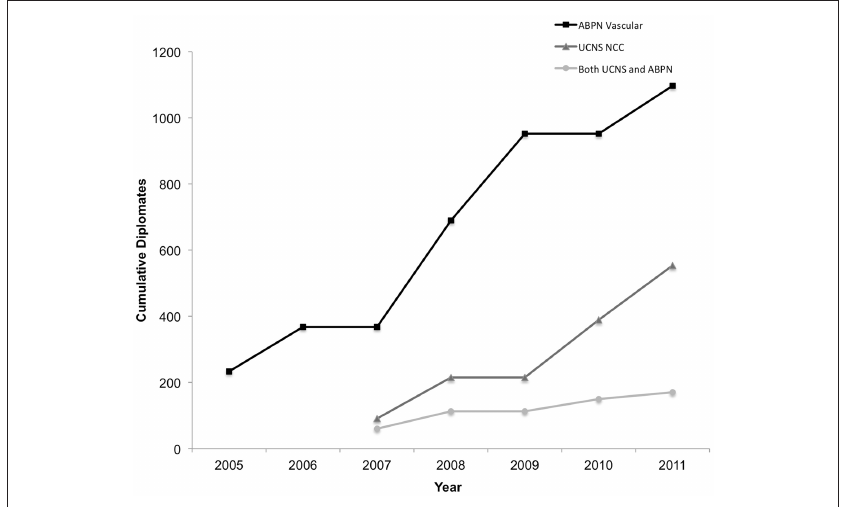
Figure 1 | Cumulative number of diplomates by year and certification(s) held. NCC, Neurocritical